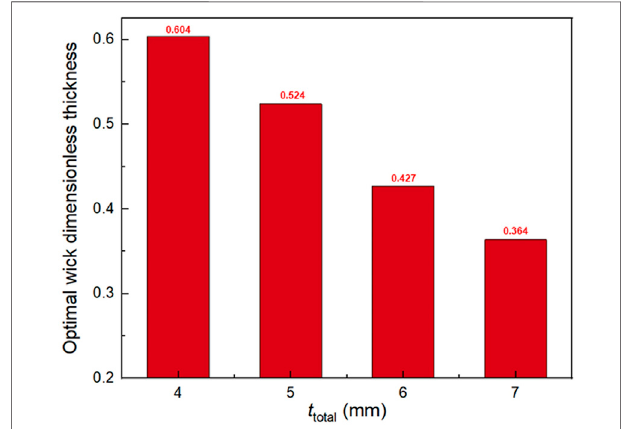
FIGURE 14 | Optimal dimensionless thicknesses under different values of ttotal